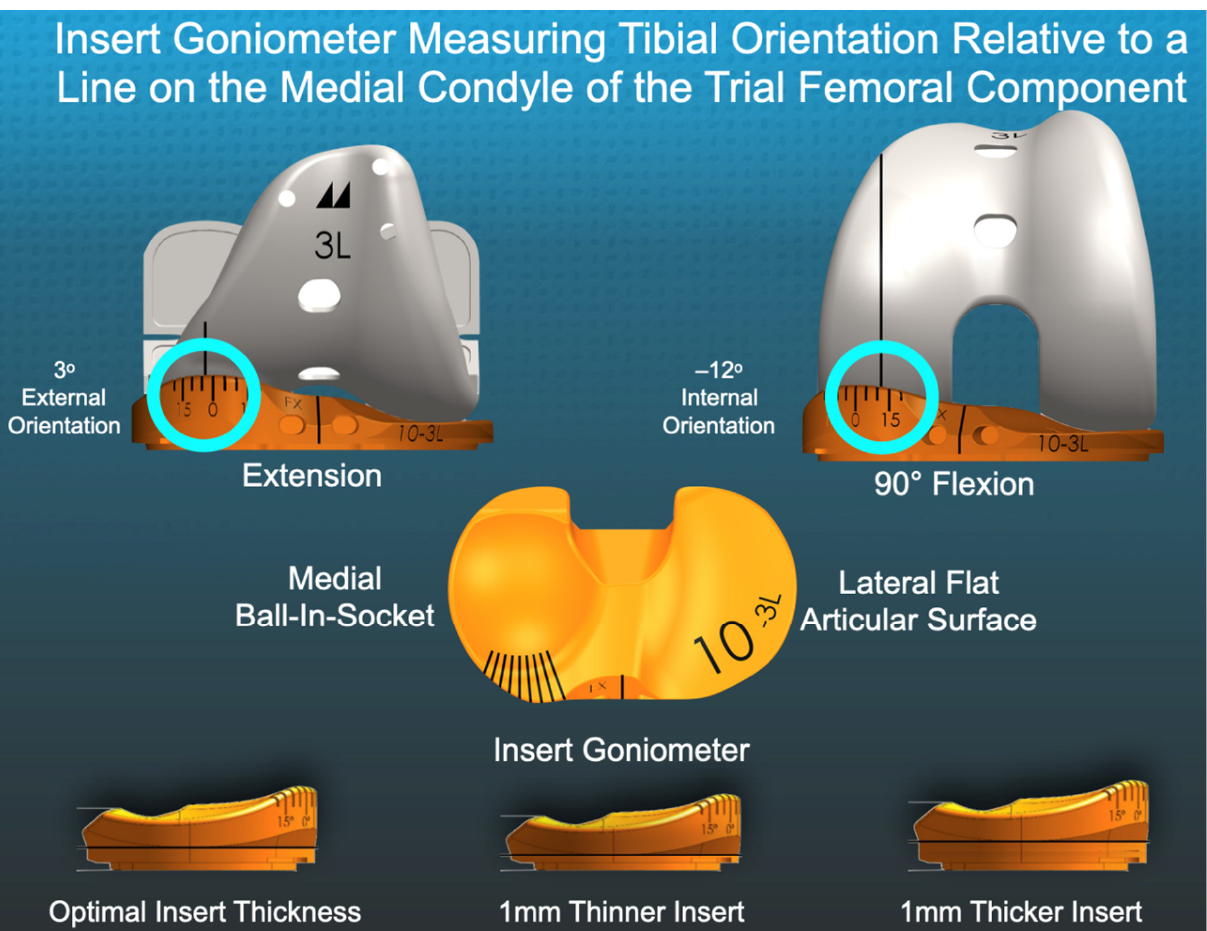
Figure 1. The composite shows the intersection of the sagittal reference line on the femoral trial component with the trial insert goniometer’s angular scale (blue circles), which measured 3° external orientation in extension and − 12° internal orientation at 90° flexion.